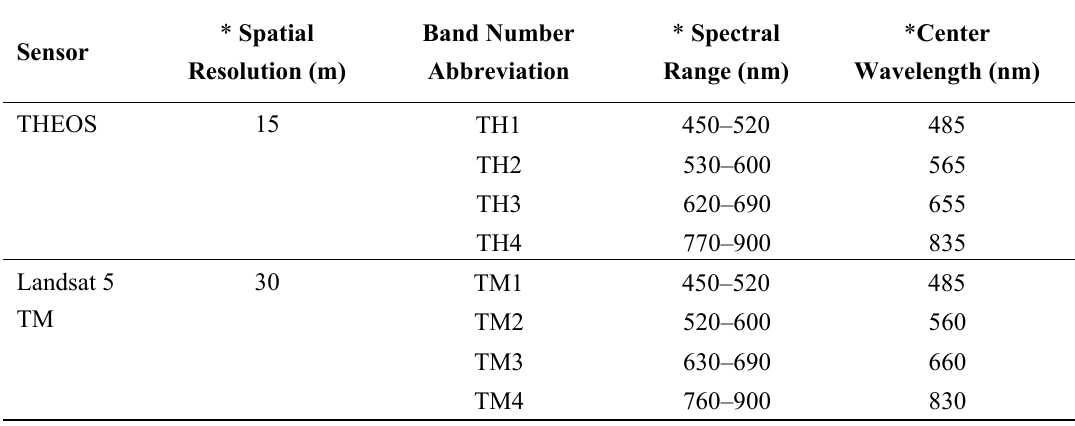
Table 2. Sensor characteristics of four multispectral bands of THEOS and Landsat 5 TM used in the